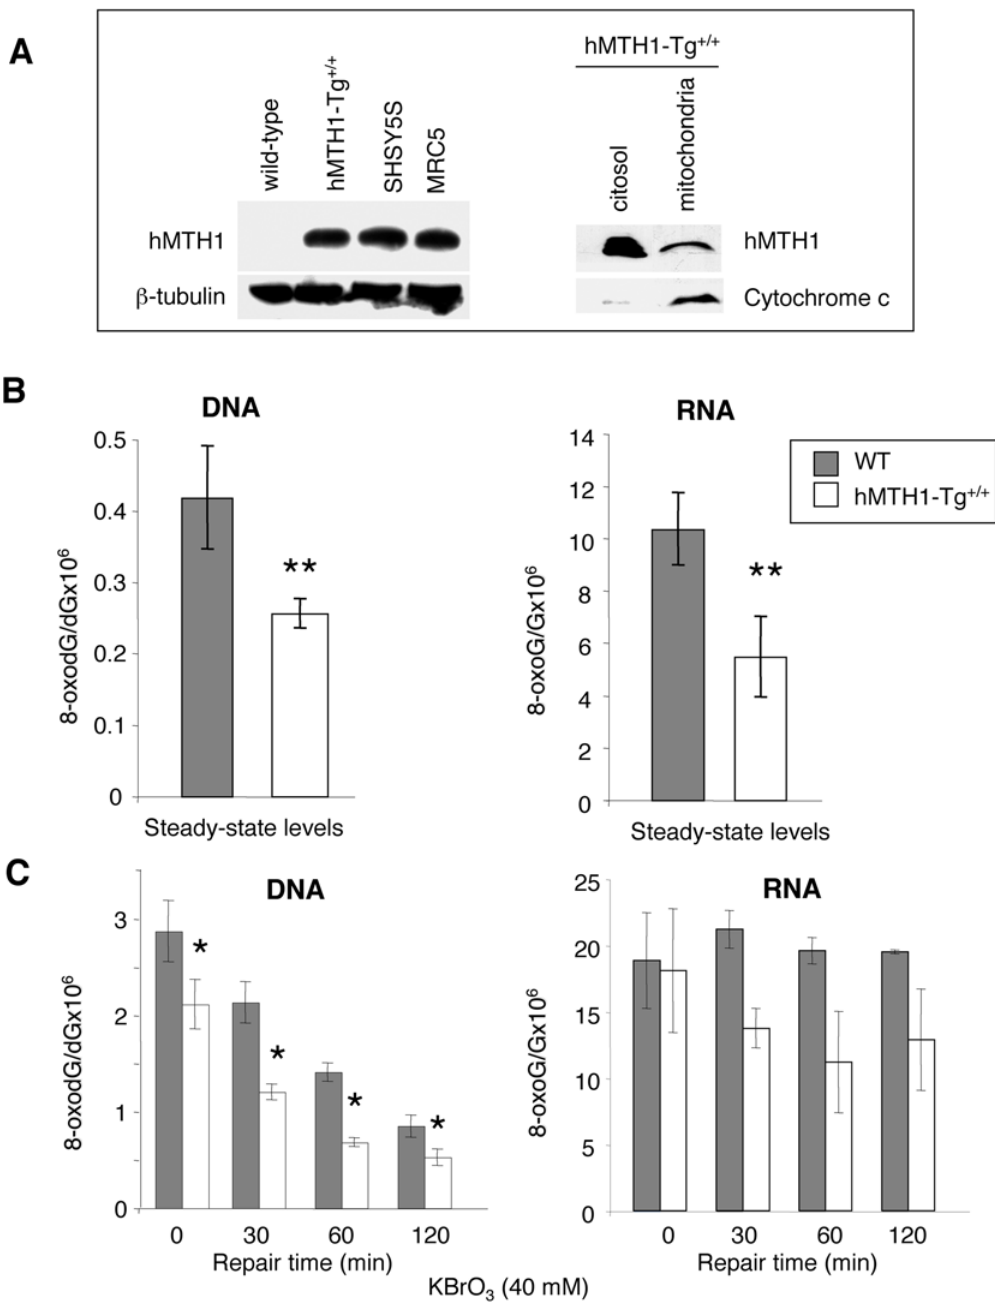
Figure 2. hMTH1 protein in hMTH1-Tg + / + MEFs and protection against oxidative stress. (A) Expression of hMTH1 in wild-type and homozygous hMTH1-Tg + / + MEFs. Total cell extracts were separated by 12%-SDS polyacrylamide electrophoresis, blotted and probed with an antibody against hMTH1 [23]. The human SHSY5S neuroblastoma and SV40-transformed MRC5 cell lines are shown for comparison (left panel). Western blotting of subcellular fractions of hMTH1-Tg + / + MEFs with anti-hMTH1 (right panel). Proteins were separated on 18%-SDS polyacrylamide electrophoresis and cytocrome c was used to quantify mitocondrial cell extracts. (B) Steady-state levels of oxidized guanine. DNA and RNA from wild- type (filled bars) and hMTH1-Tg + / + (open bars) MEFs were digested to nucleosides and 8-oxodG and 8-oxoG were separated and quantified by HPLC- EC. Values are expressed as ratio to DNA and RNA guanine, respectively. Values are the mean 6 SE of 3 independent determinations. Asterisks indicate statistically significant differences (p-value=0.005 and 0.015 for DNA and RNA, respectively; t -test). (C) Levels of oxidized guanine following oxidant treatment. 8-oxodG and 8-oxoG were measured by HPLC-EC in DNA and RNA extracted from MEFs exposed to 40 mM KBrO 3 for 30 min (time 0) and after the indicated times of repair incubation in drug-free medium (30, 60, 120 min). Wild type (filled bars) and hMTH1-Tg + / + (open bars). Values are the mean 6 SE of 3 independent determinations. Asterisks indicate a p-value # 0.05; t -test.